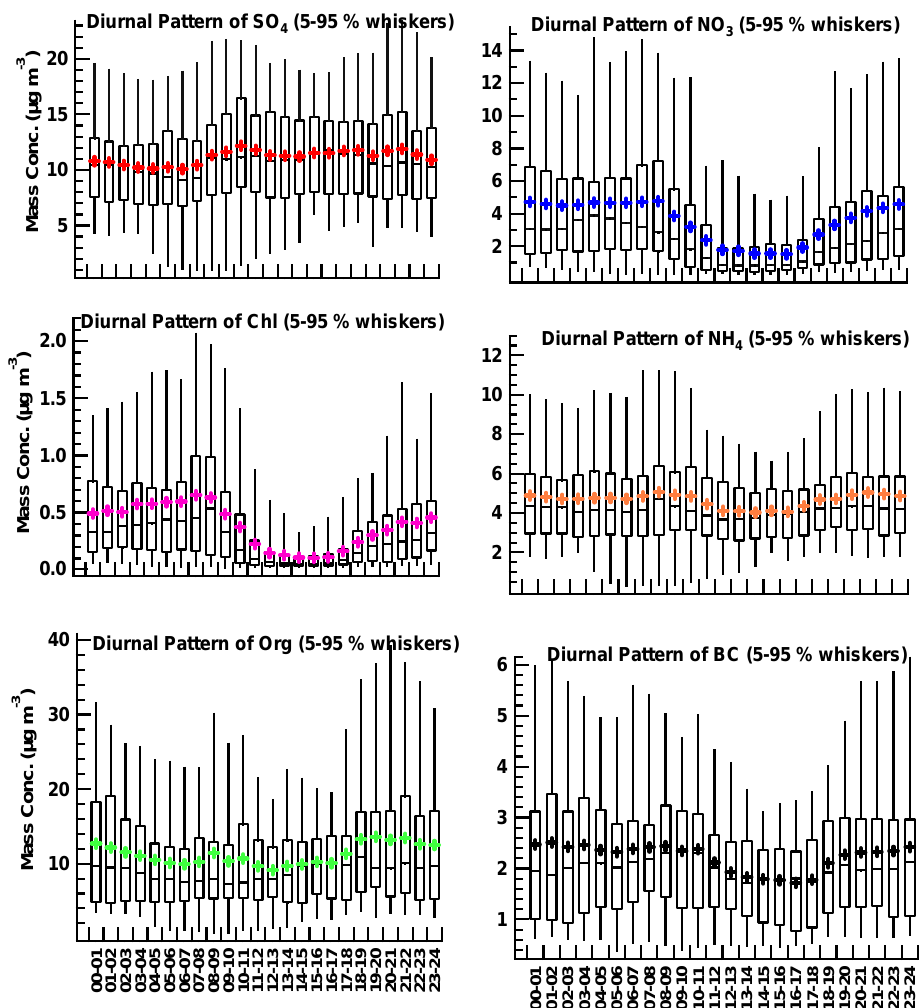
Fig. 3. Diurnal variation box plots of PM 1 species. The upper and lower boundaries of boxes indicate the 75th and 25th percentiles; the line within the box marks the median; the whiskers above and below boxes indicate the 90th and 10th percentiles; and cross symbols represent the means.